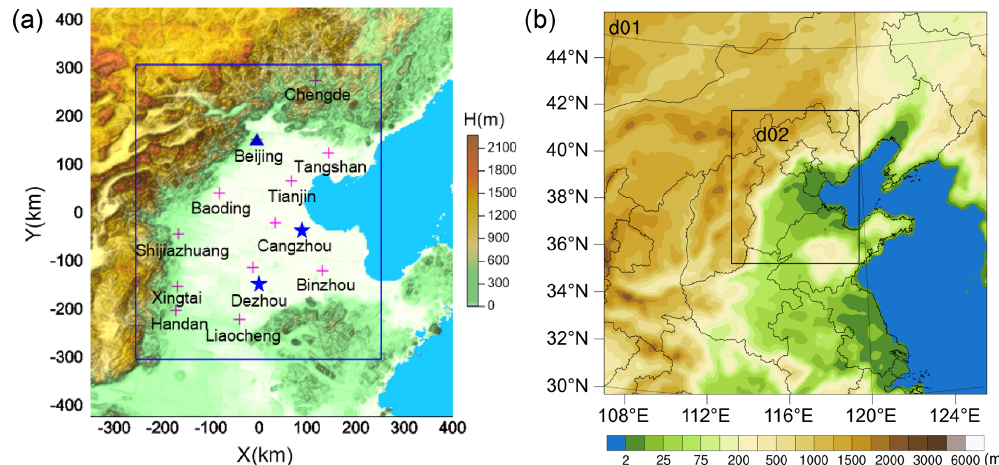
Figure 2. Geographical map of the (a) observation area and (b) WRF model domain. Intensive GPS soundings at Dezhou and Cangzhou (star), routine radiosonde sounding at Beijing (triangle) and air quality stations (plus) are indicated in (a) . The rectangle in (a) is the same as the model inner domain d02 in (b)